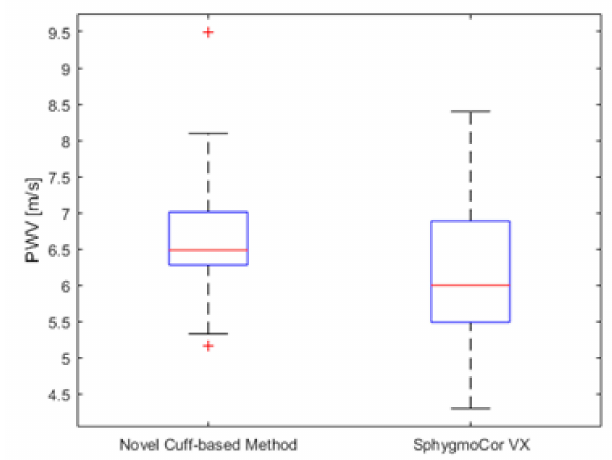
Figure 3. Device comparison of PWV